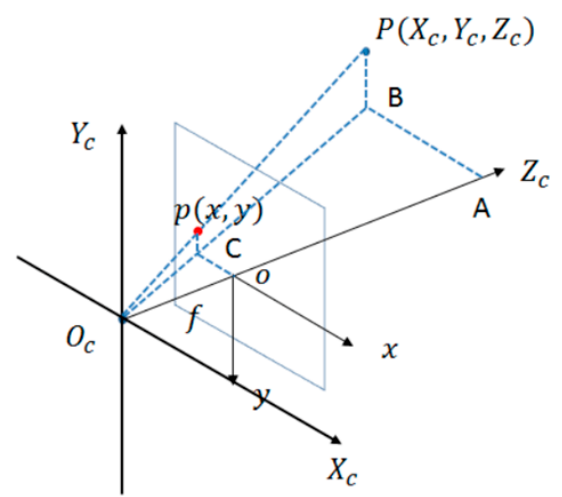
Figure 3. The schematic diagram of the pin-hole imaging.